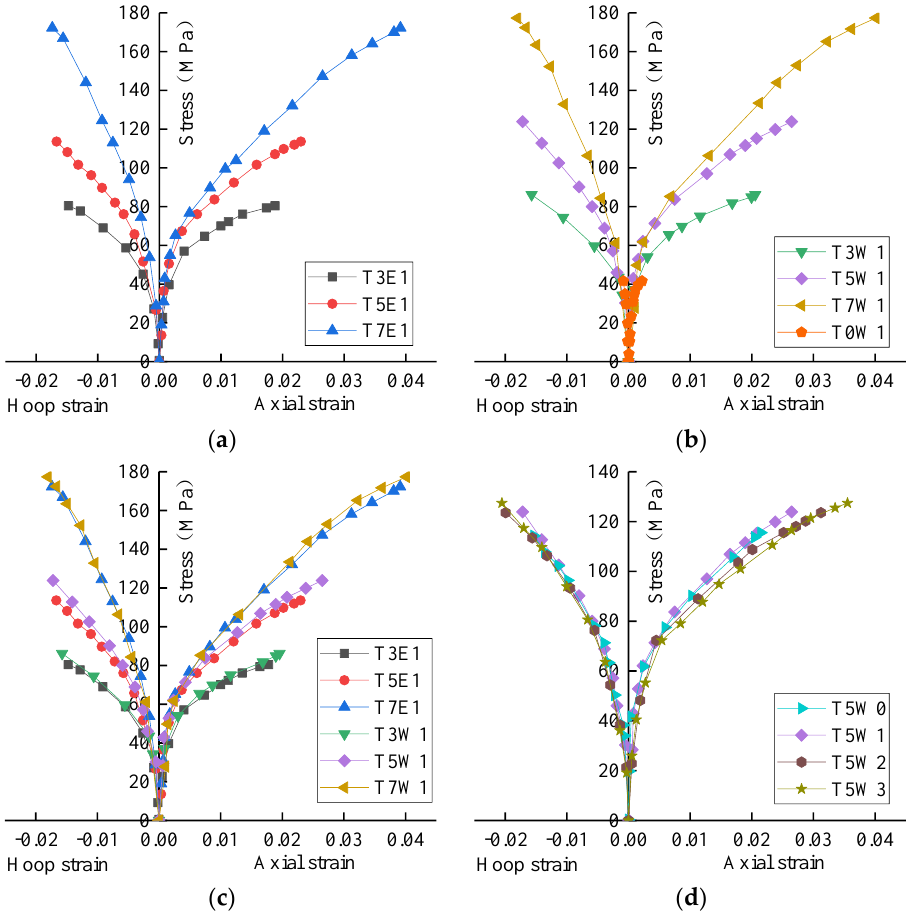
Figure 5. Specimen stress and axial and hoop strain. ( a ) Different tube thickness. ( b ) Different tube thickness. ( c ) Different fiber shapes. ( d ) Different fiber volume fraction.